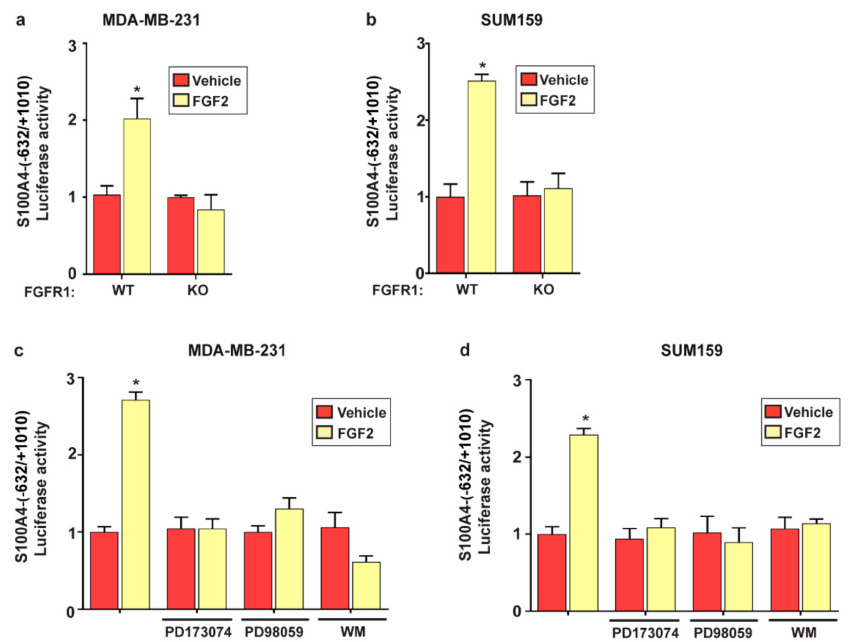
Figure 3. The FGF2/FGFR1-mediated signaling activates the S100A4 promoter construct. ( a , b ) Lu- ciferase activities of the S100A4 promoter construct in FGFR1 (WT) and FGFR1 (KO) MDA-MB-231 and SUM159 cells treated for 18h with vehicle and 25 nM FGF2. ( c , d ) Luciferase activities of the S100A4 promoter construct in MDA-MB-231 and SUM159 cells treated for 18h with vehicle and 25 nM FGF2 alone and in combination with 1 µ M FGFR1 inhibitor PD173074, 1 µ M MEK inhibitor PD98059, or 100 nM PI3K inhibitor Wortmannin (WM), as indicated. The luciferase activities were normalized to the internal transfection control and values of cells receiving vehicle were set as 1-fold induction upon which the activities induced by treatments were calculated. Each column represents the mean ± SD of three independent experiments performed in triplicate. (*) indicates p <